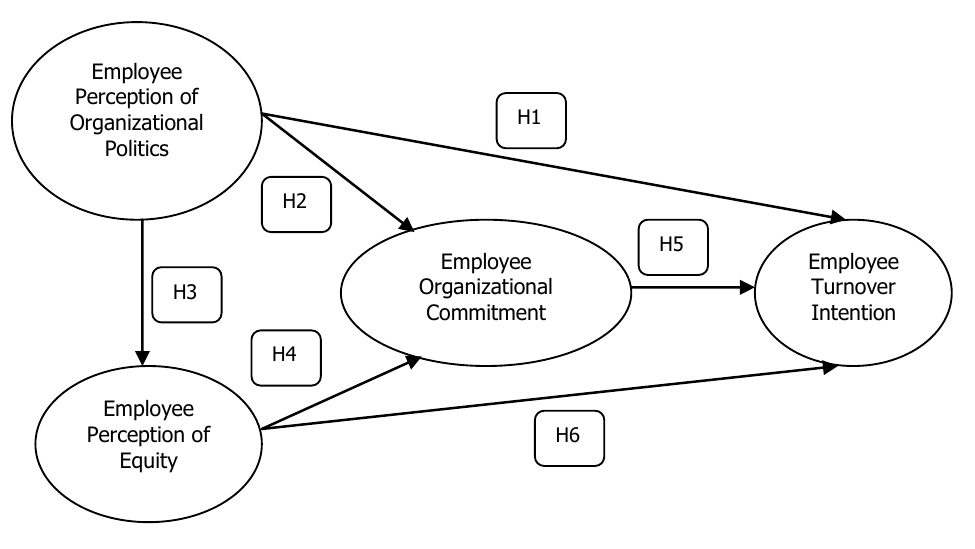
Figure 1: Conceptual